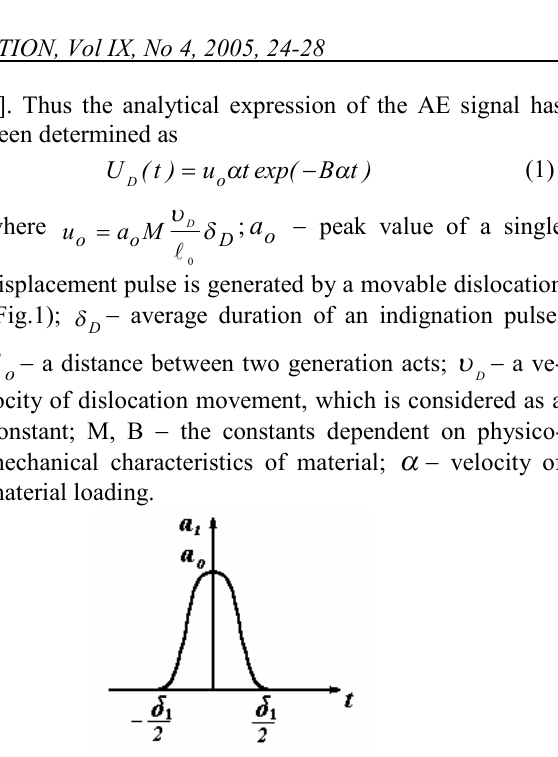
Fig. An indignation pulse at separation of a single dislocation or at overcoming the dislocation barrier When developing an AE signal model from plastic deformation, it was considered that the deformation of material occurs at a constant temperature that does not in- fluence its physico-mechanical characteristics. At that time, the parameters that are included into the description of the resulting AE signal (1) and that are connected to the movement of dislocations depend on temperature. It of dislocation, and the number of movable dislocations [8, *